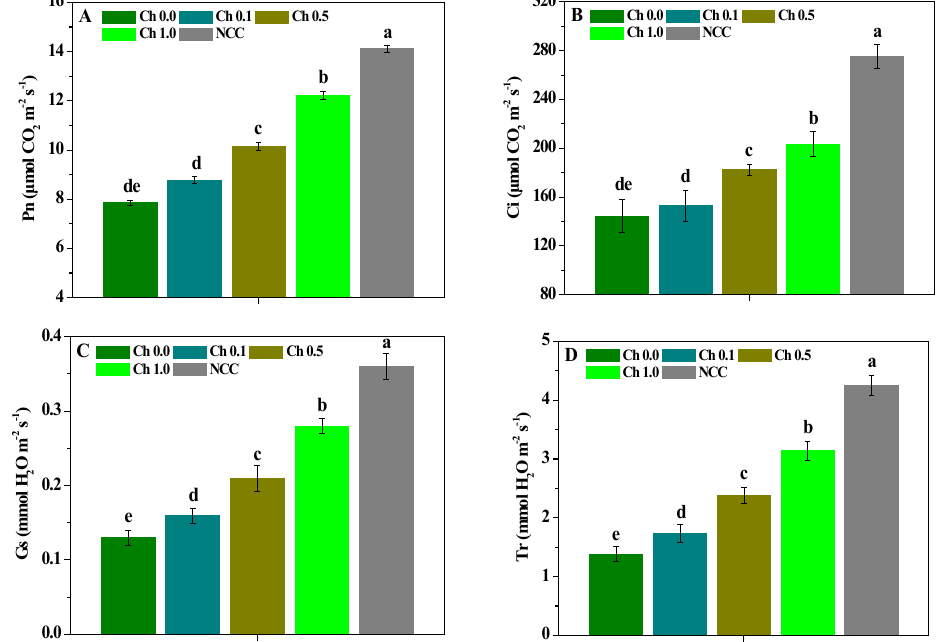
Figure 3. The influence of chitosan spraying on the Pn ( A ), Ci ( B ), Gs ( C ), and Tr ( D ) contents of P. ternata leaves. Error bars show SD, and different letters indicate significant differences at 5% ( p < 0.05) level.